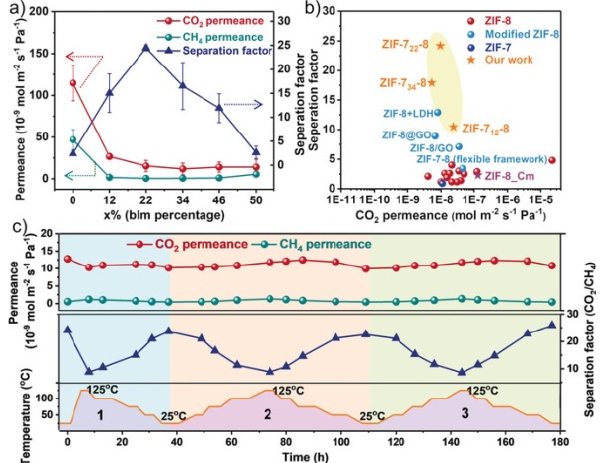
Figure 20. ( a ) CO 2 /CH 4 separation performance of the mixed-linker ZIF-7 x -8 membranes. The ZIF-7 22 -8 membrane shows the highest CO 2 /CH 4 separation factor of 25. ( b ) Comparison of CO 2 /CH 4 separation performance of our ZIF-7 x -8 membranes with other ZIF membranes. ( c ) Temperature swing stability of the ZIF-7 22 -8 membrane for CO 2 /CH 4 separation. Reprinted with permission from [205], Copyright (2019) John Wiley and Sons publications.